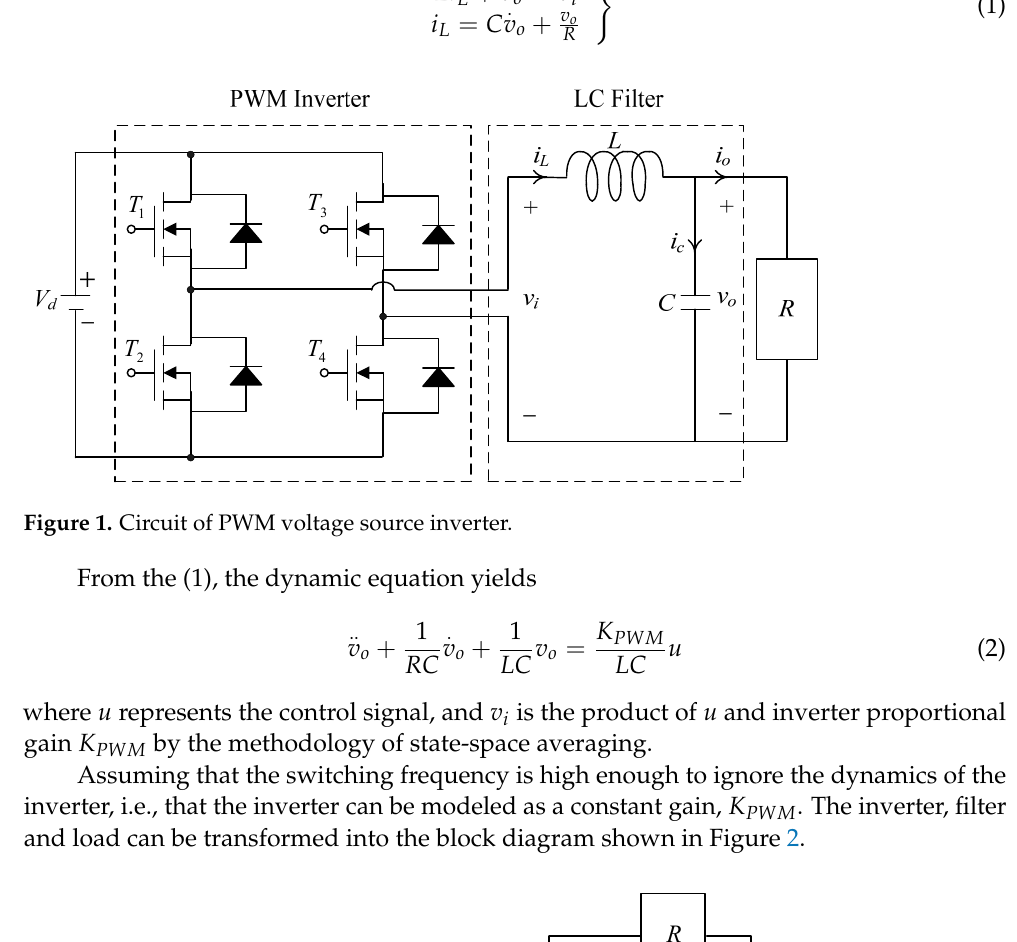
Figure 2. Linear model of PWM voltage source inverter. The block diagram of a PWM voltage source inverter with the proposed controller is shown in Figure 3. This method senses the voltage in the capacitor and uses the sensing signal to control the voltage feedback loop to ensure a sinusoidal output voltage.